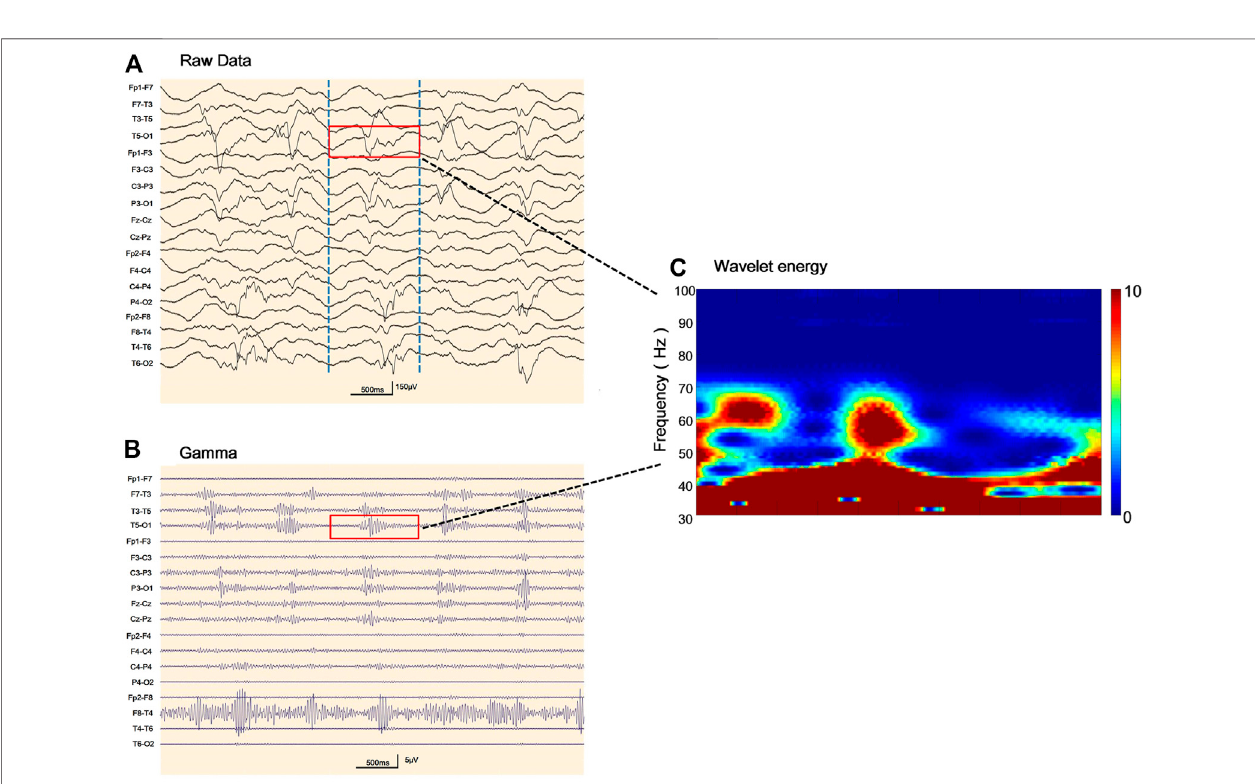
FIGURE 3 | Representative electroencephalogram (EEG) follow-ups and corresponding gamma oscillations (A) Raw EEG with the pattern of rhythmic high amplitude delta waves with superimposed (poly) spikes (RHADS) in sleep during stage II non-rapid eye movement period, the red layout marks 1 s data (B) EEG corresponding to Figure 3A after 30 – 80 Hz fi ltering, the red line addresses the gamma oscillations visually identi fi ed (C) Veri fi cation of gamma oscillations. Utilizing the wavelettransformmethod,thetime-frequencyspectraexhibitspectralblobsataround30 – 80 HzintheregionT5-O1inassociationwiththecorrespondingspikes.